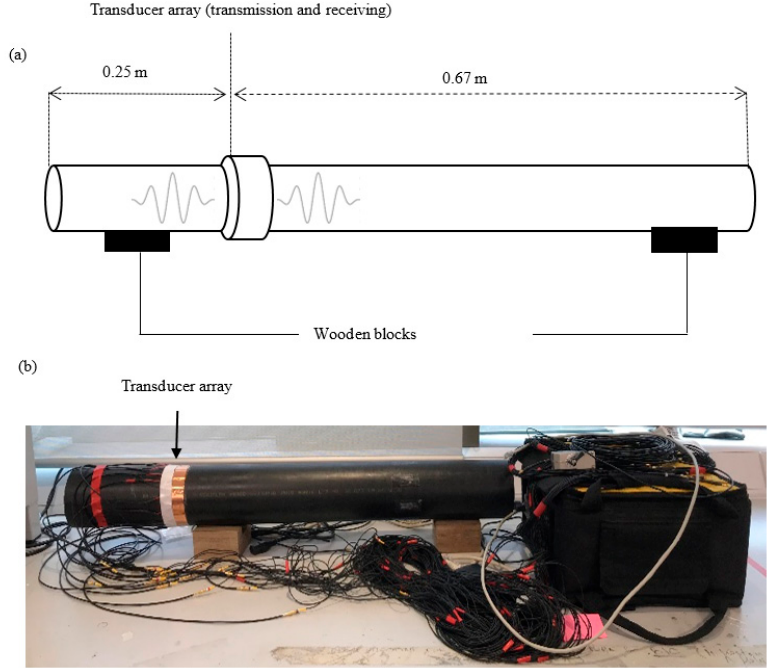
Figure 4. Laboratory experimental setup: ( a ) schematics; ( b ) setup.